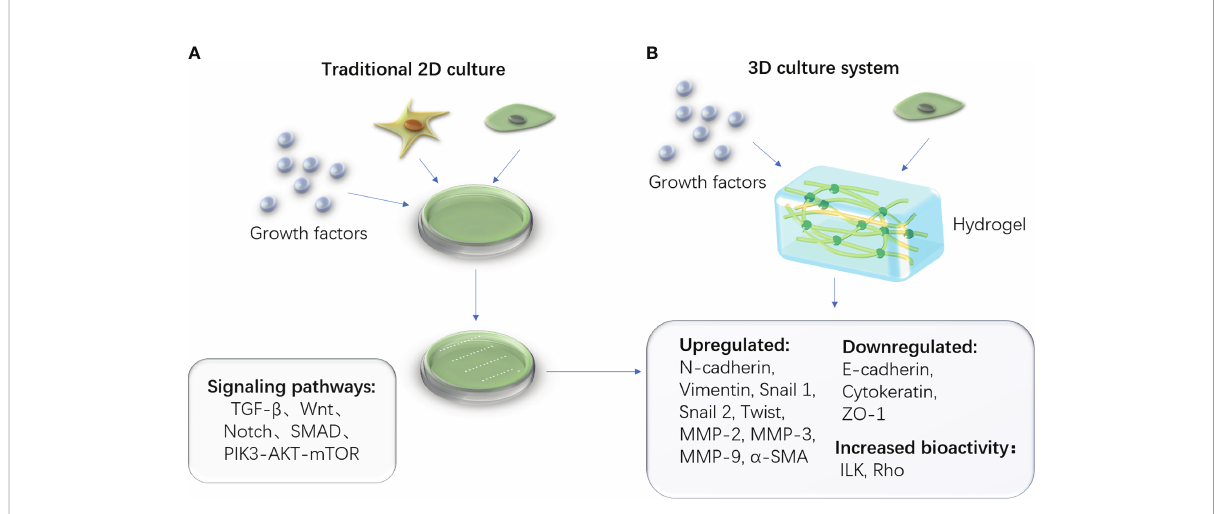
FIGURE 3 Traditional 2D cell culture system and advanced 3D cell culture system. (A) The schematic diagram of the traditional 2D culturing method, which contains stem cells and necessary cytokines in a culture medium. (B) The schematic diagram of a novel 3D culturing method in which the culture medium is replaced by the biomaterial